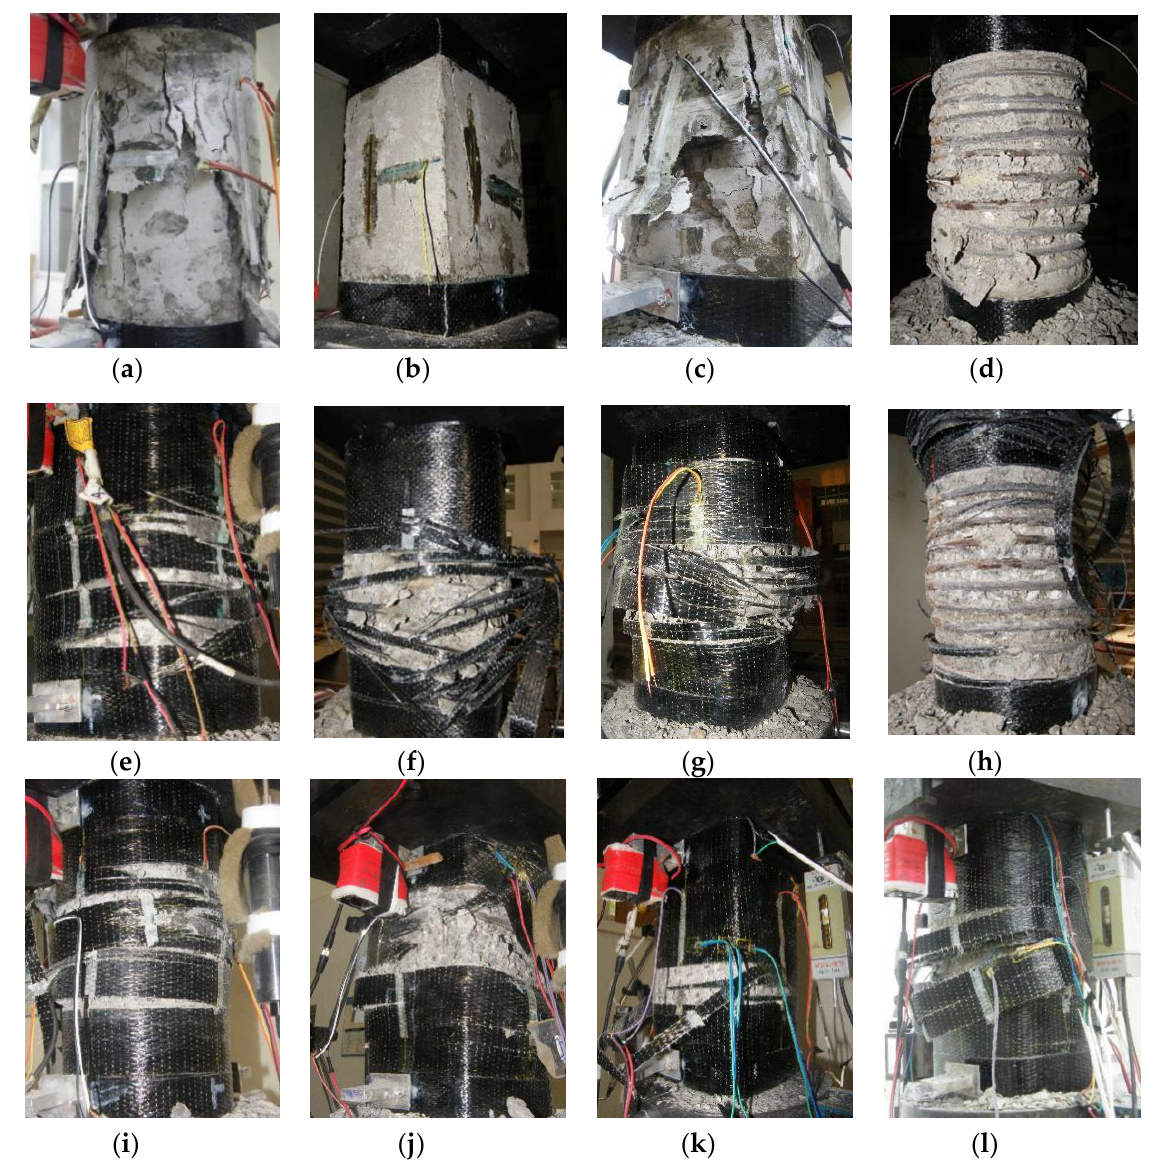
Figure 5. Typical failure modes of the specimens: ( a ) PC-BC; ( b ) PC-CS; ( c ) SR5S20BN; ( d ) SR75S20CN;